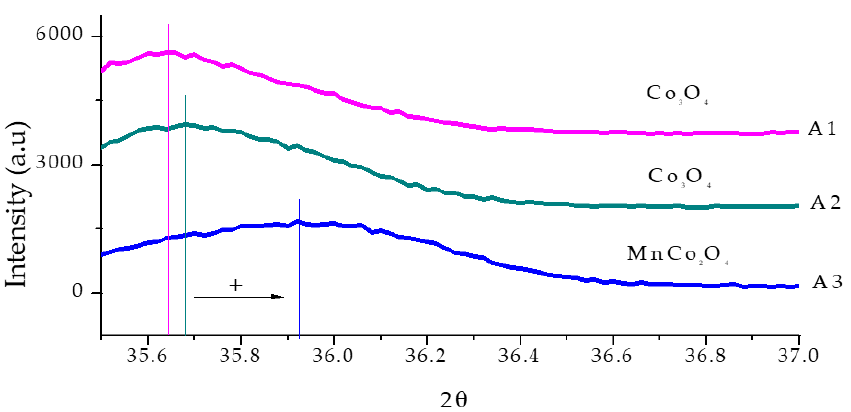
Figure 6. X-ray di ff ractograms for coated A1, A2 and A3 samples and uncoated AISI 430 sample after Figure 6. X-ray diffractograms for coated A1, A2 and A3 samples and uncoated AISI 430 sample after thermal oxidation process at 800 ◦ C for 300 h. thermal oxidation process at 800 °C for 300 h.